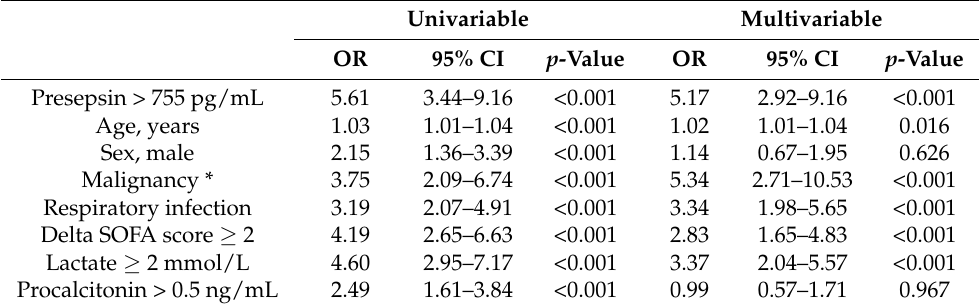
Table 2. Univariate and multivariable logistic regression analysis for 28-day mortality.